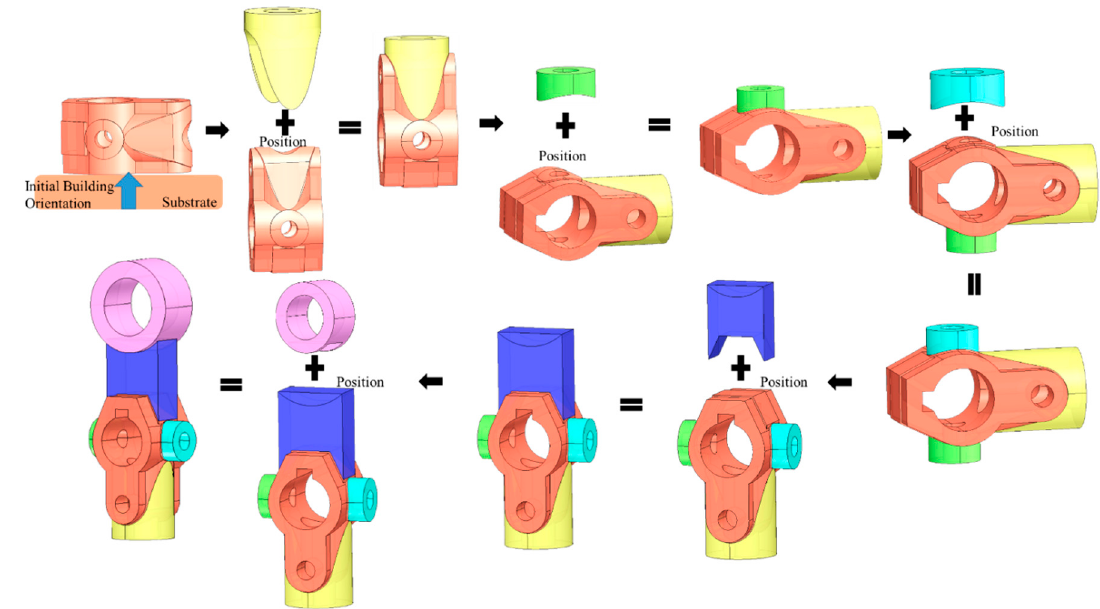
Figure 10. Process planning with first defined initial building orientation for model (a).